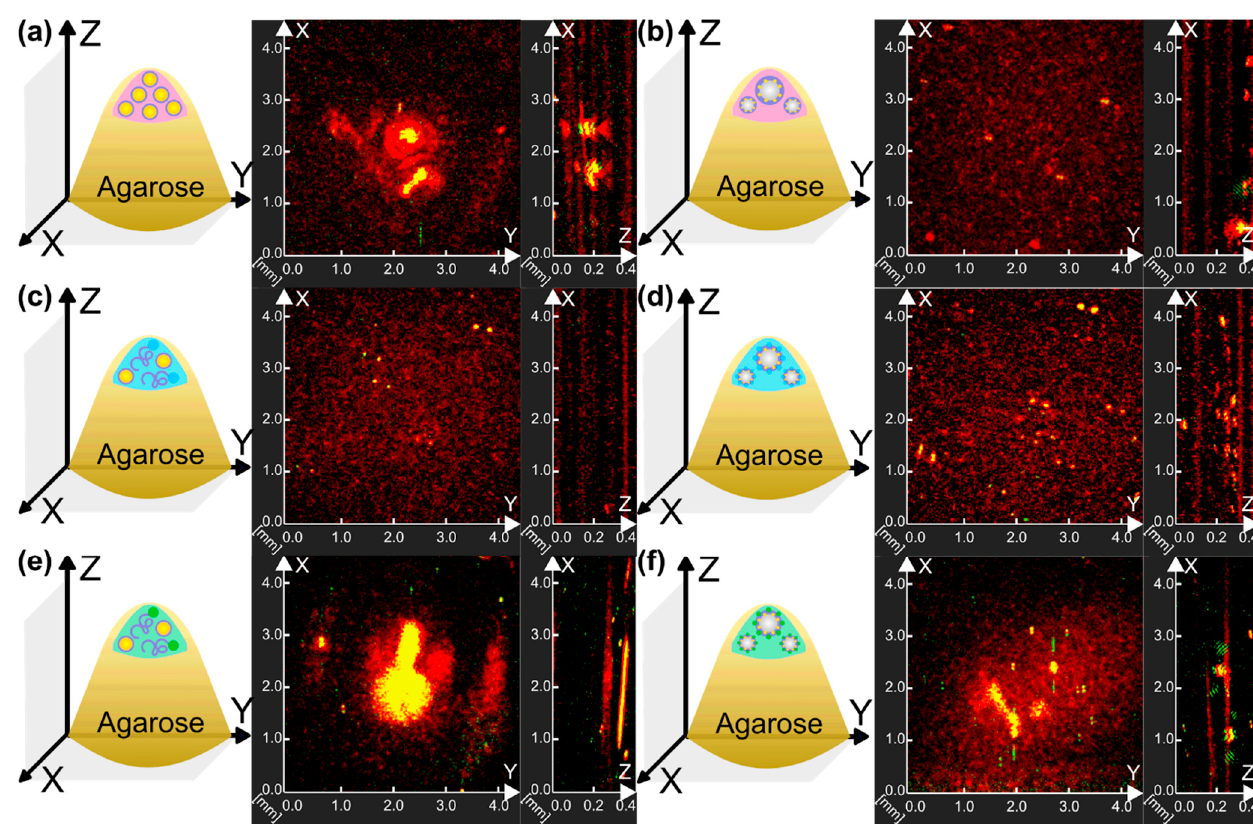
Figure 8. Schematic representation of the agarose phantoms and raster-scanning optoacoustic mesoscopy measurements of ( a ) AuNPs solution, ( b ) BSA-AuNPs MBs, ( c ) BSA-ZnPc and AuNPs solution, ( d ) BSA-ZnPc-AuNPs MBs, ( e ) BSA-ICG and AuNPs solution, ( f ) BSA-ICG-AuNPs MBs. Projections of measurements in X and Y, X and Z axes are presented, and the corresponding projections are marked in gray in the schematic representations for each measurement.